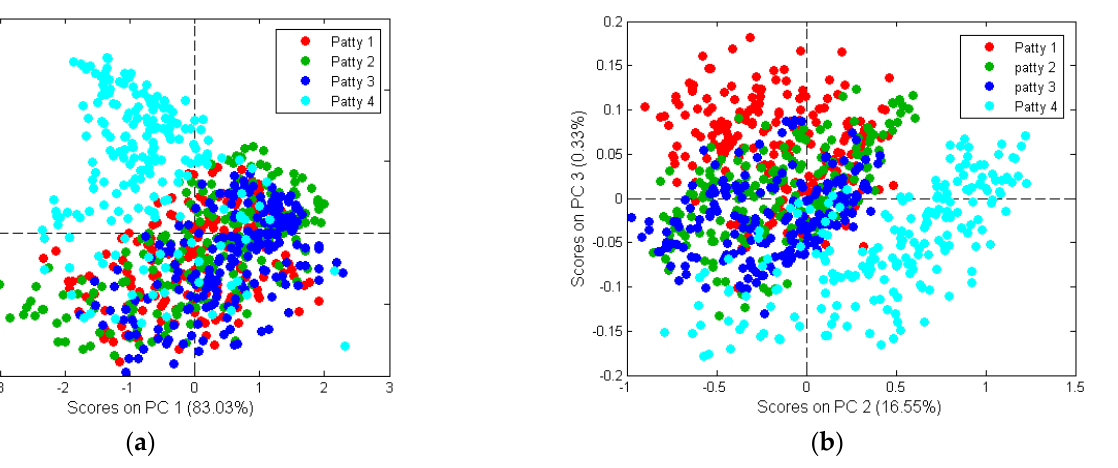
Figure 7. PCA analysis of Patty 1 ( red ), Patty 2 ( green ), Patty 3 ( blue ) and Patty 4 ( turquoise ) categories. Minimal/gradual class separation was observed. Scores illustrated as ( a ) PCA score plot of PC1 (83.03%) vs. PC2 (16.55%); and ( b ) PCA score plot of PC2 (16.55%) vs. PC3 (0.33%).